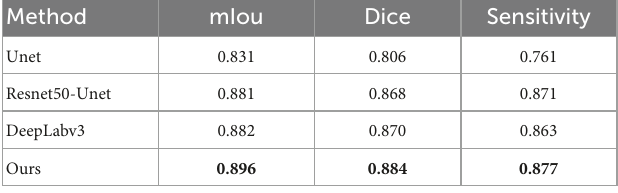
TABLE 1 mIOU, dice coefficient, and sensitivity for tear meniscus region segmentation by different methods. Method mIou Dice